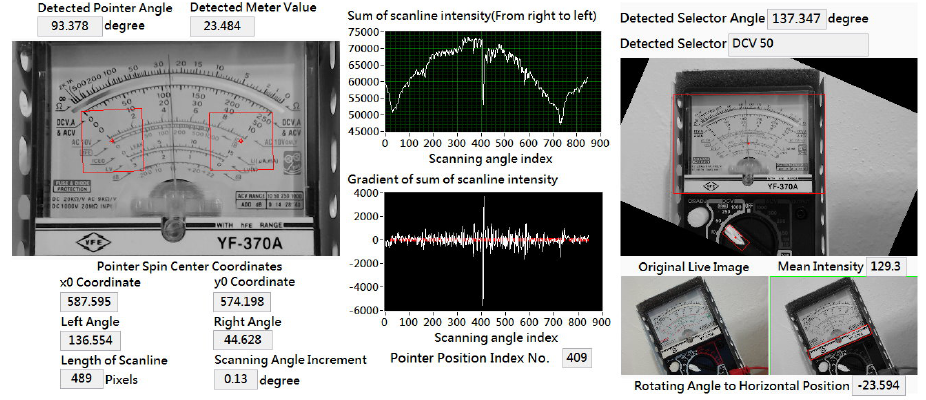
Figure 18. An illustrative result directly displayed on the LabVIEW environment for scenario (5), “A-meter rotated left” (23.484 ◦ ), presented in Section 5.3.